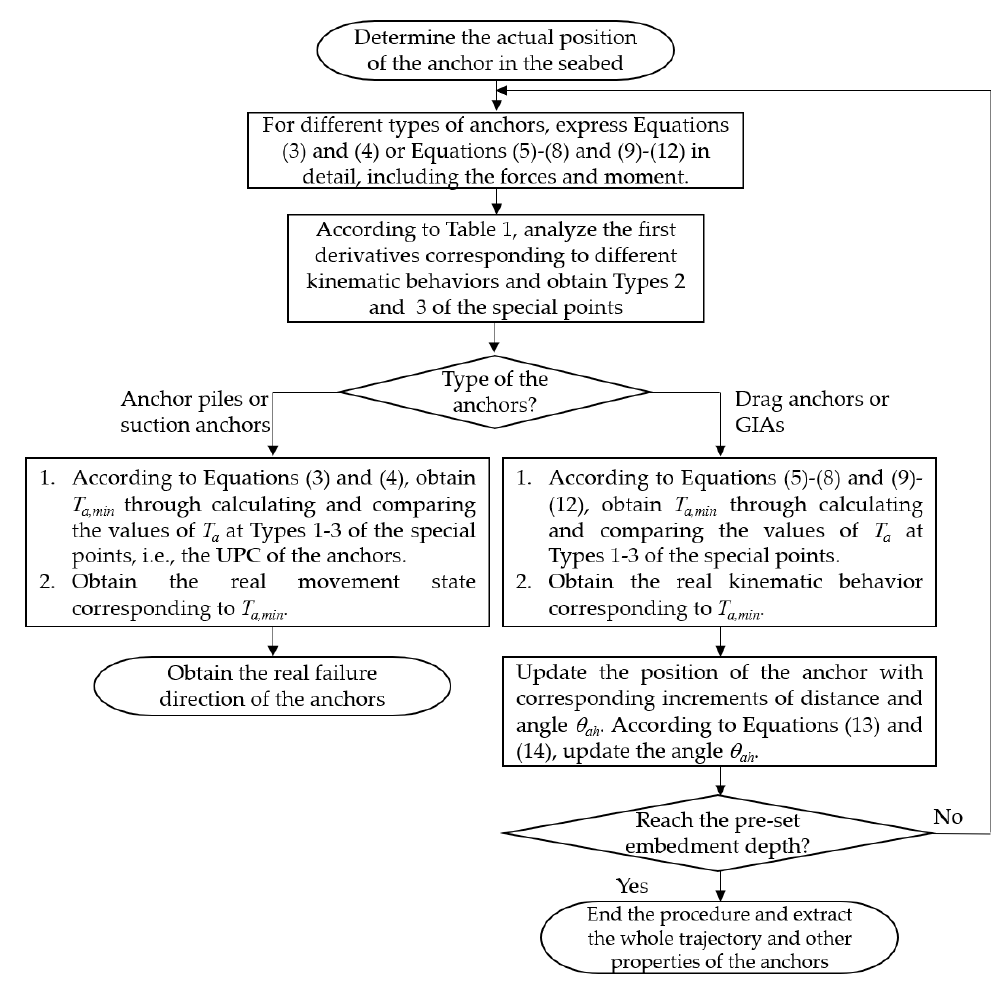
Figure 6. Calculation flowchart.